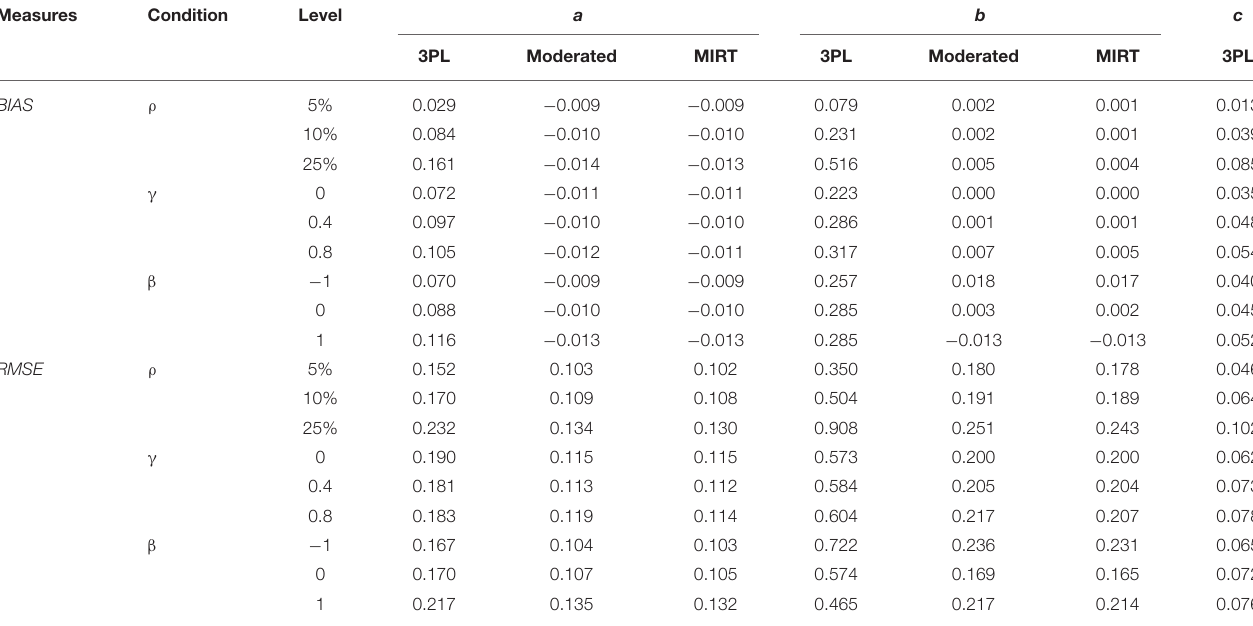
TABLE 3 | BIAS and RMSE of item parameter estimates under different models in study II. Measures